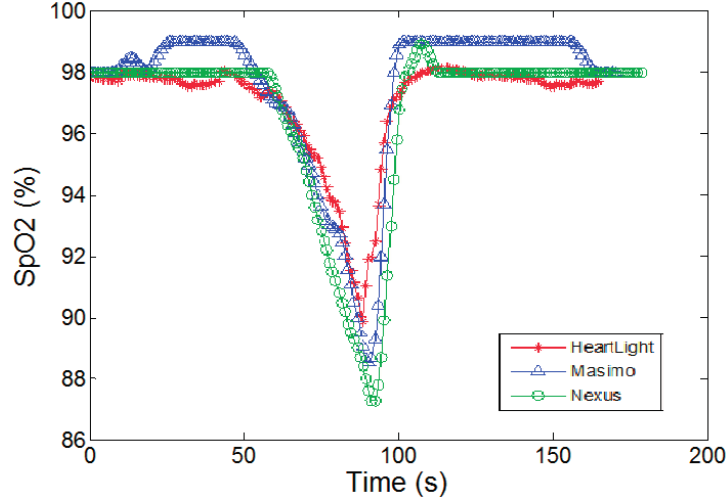
Figure 7. Comparison of the SpO2 values for the CMOS sensor and two commercial devices (Masimo Radical 7 and Nexus-10) in transmission mode for a breath hold and release experiment.